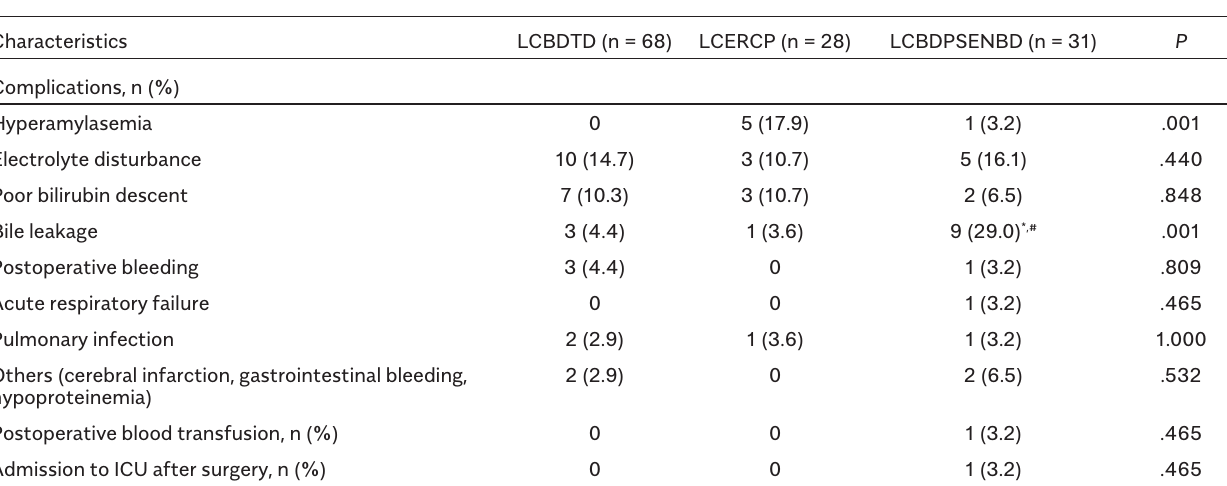
Table 5. Comparison of the Safety of Different Surgical Methods